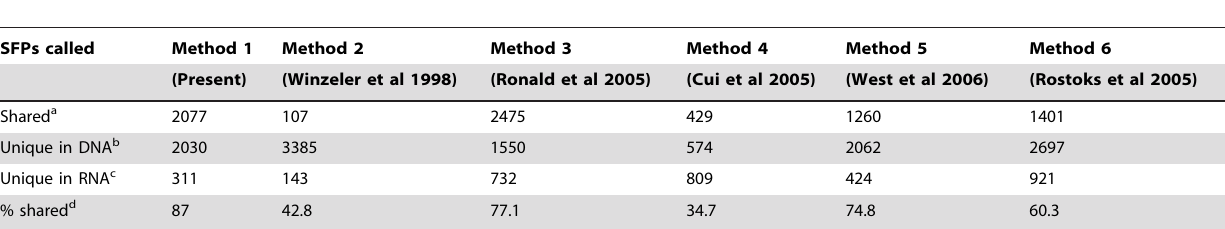
Table 1. The number of SFPs detected by the present and other methods from the yeast genomic DNA and RNA microarray datasets.